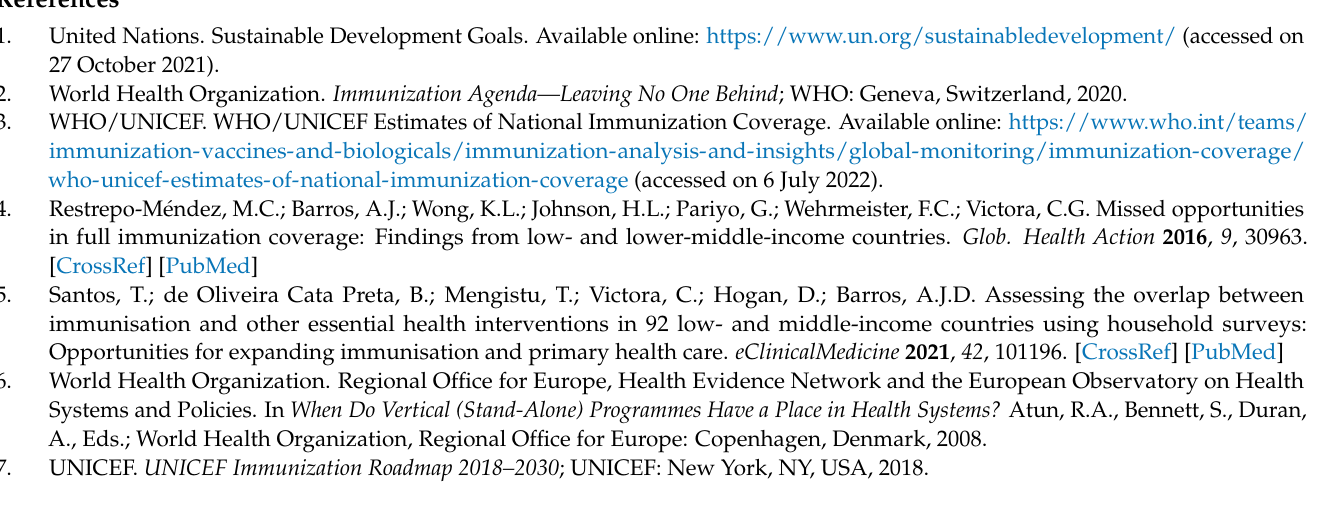
and each multiple deprivation indicator for each survey included in the analysis at individual level. Table S2: Surveys included in ecological analysis. Figure S1: Prevalence of each indicator according to deprivation index quintiles (countries with information on LLIN). No-DPT was one of the variables used in the PCA. Figure S2: Prevalence of no-DPT according to deprivation index quintiles (all countries). No-DPT was not included in the